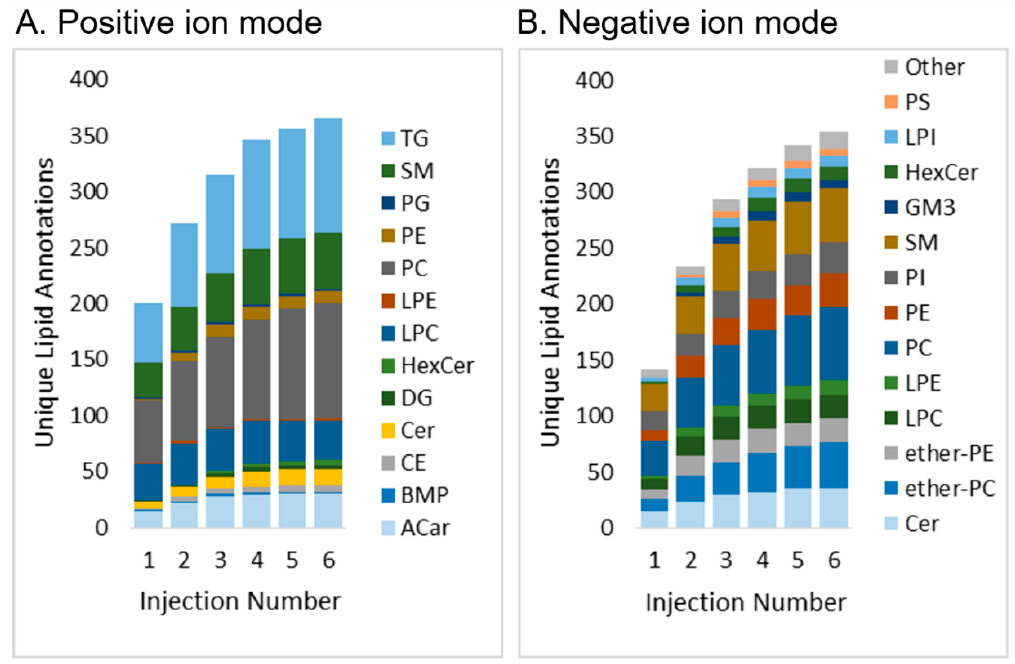
Figure 5. Iterative exclusion in positive ( A ) and negative ( B ) ion mode, showing an increase in the number of annotations over injections when using iterative exclusion. Acronyms are defined in Appendix B.